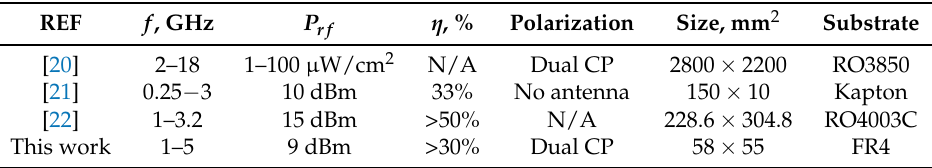
Table 3. Comparison of this study with the relevant research reported in the